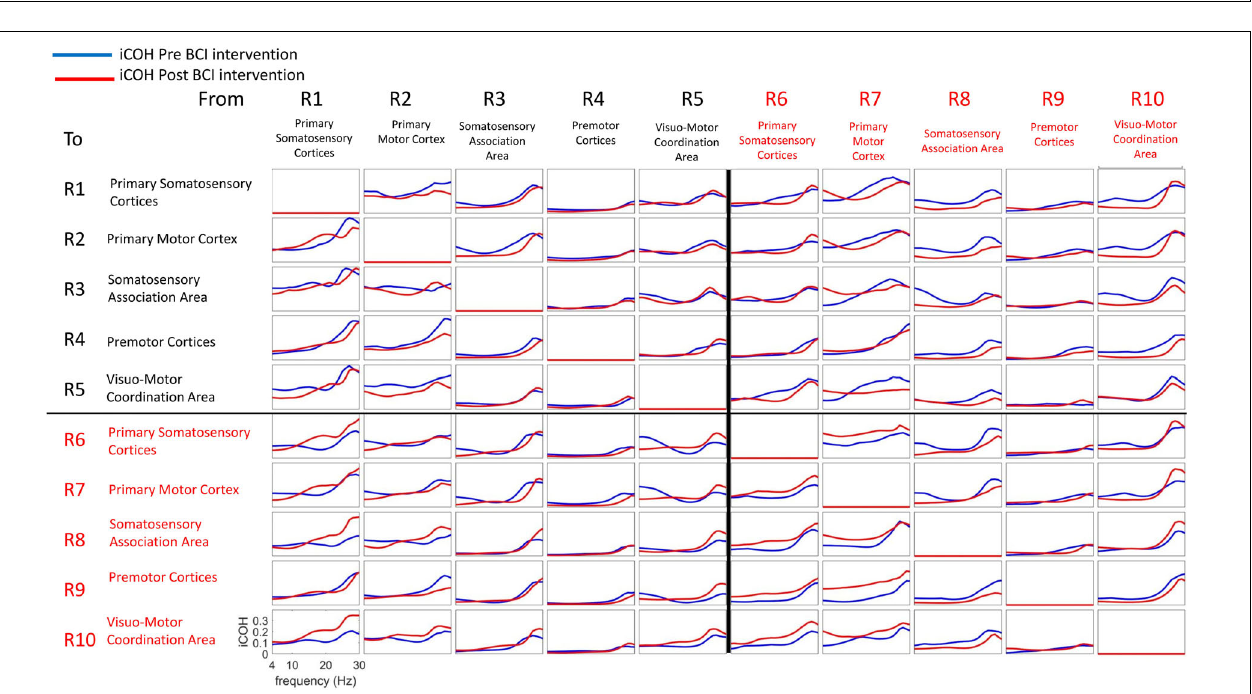
FIGURE 5 | (A) Increase in Mu rhythm desynchronization in ROI #7 (i.e., ipsilesional primary motor cortex), Post vs. Pre BCI intervention, is significantly correlated with increase in hand grip strength (Pearson correlation coefficient r = 0.435, p = 0.046). Two data points overlap at ( − 0.20, 0.00). (B) Voxel-wise correlation of Hand Grip change with the Mu [8–12 Hz] rhythm desynchronization. The heat maps show colored r values (threshold set at r = 0.5). Scale: − 0.5 (blue) to 0 (white) to + 0.5 (red). Note that stronger ipsilesional (R) Mu rhythm desynchronization (negative values) (Post-Pre) correlates with larger increase in hand grip strength.